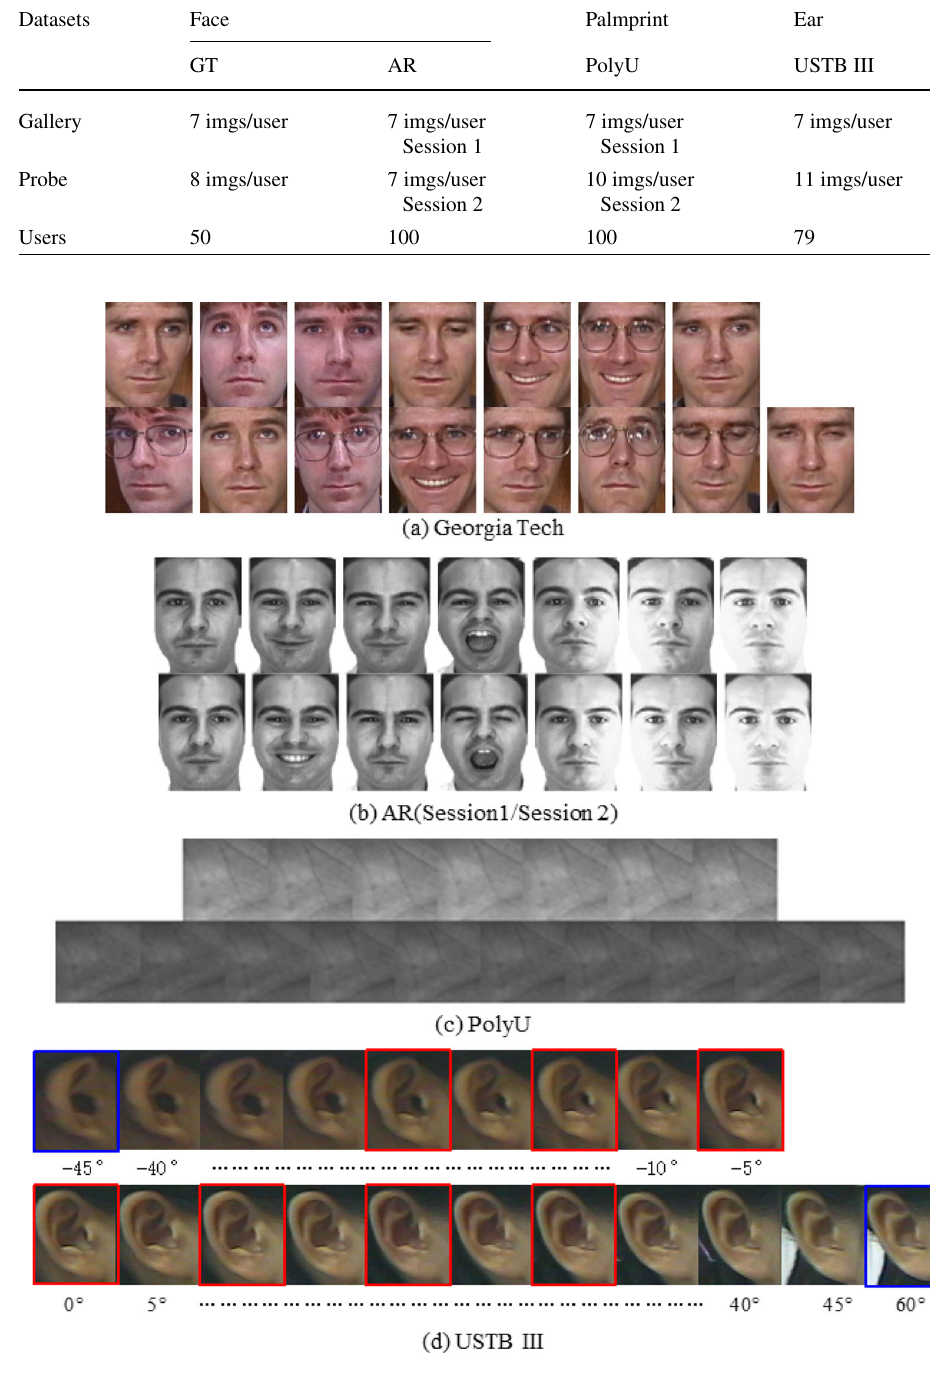
Table 1 Summary of the face, palmprint, and ear datasets